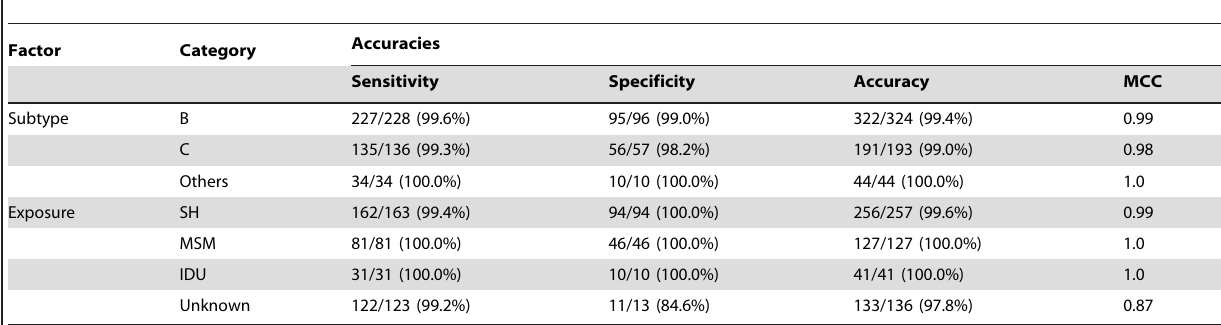
Table 3. Influence of viral subtype and transmission route over the SCBD assay’s performance on the dataset D561.